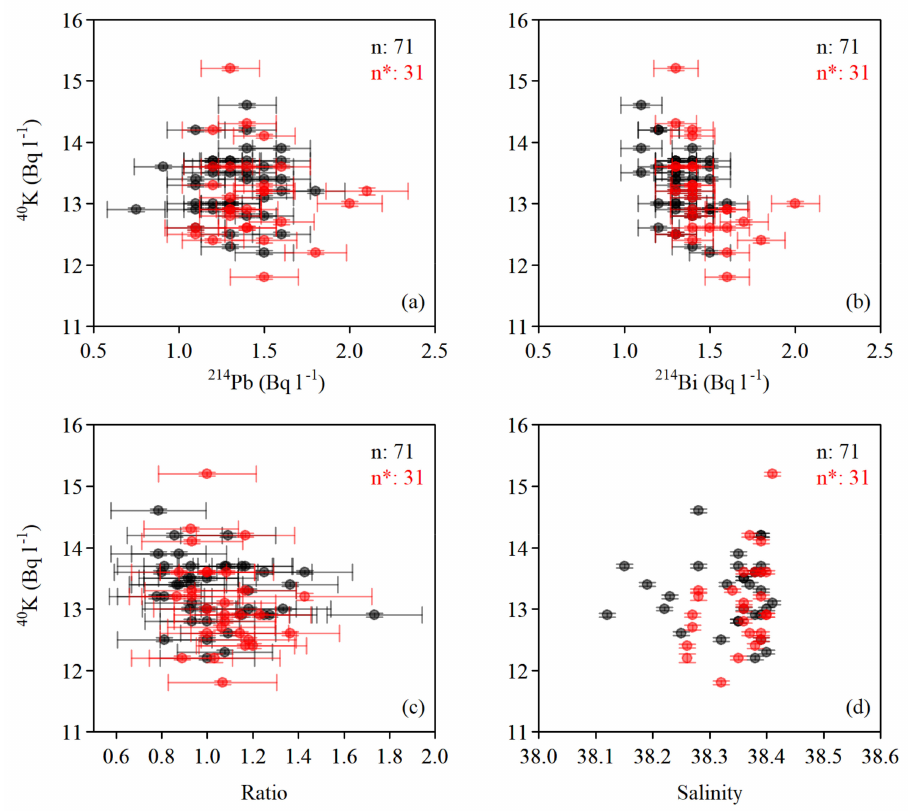
Figure 10. 40 K over radon progenies 214 Pb ( a ), 214 Bi ( b ), their ratio ( c ) and salinity ( d ) at the depth of 6 m during